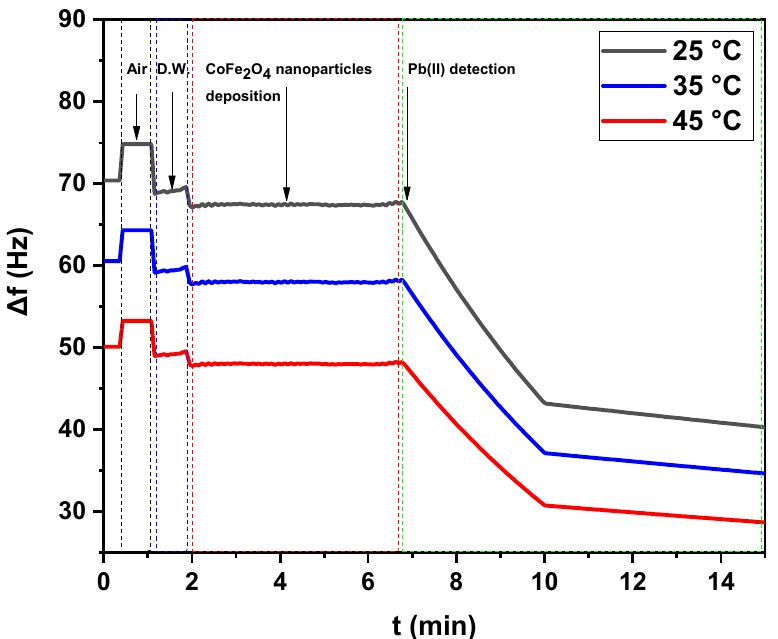
Figure 6. The net frequency shifts of the green synthesized CoFe 2 O 4 nanoparticles-coated QCM nanosensor in Pb(II) aqueous solutions with different temperatures (25 ◦ C, 35 ◦ C, and 45 ◦ C) as a function of time.